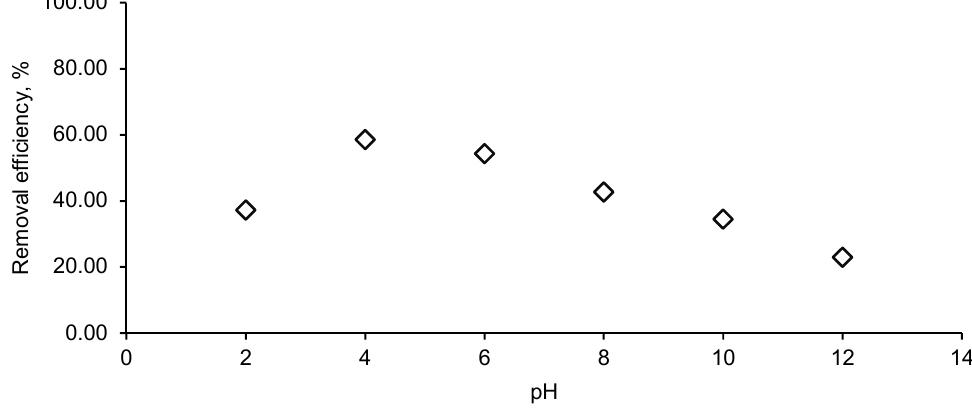
Figure 7. pH influence on CPX removal efficiency. (CPX solution volume: 25 mL; CPX initial concentration: 50 mg/L; biosorbent dose: 1 g/L).